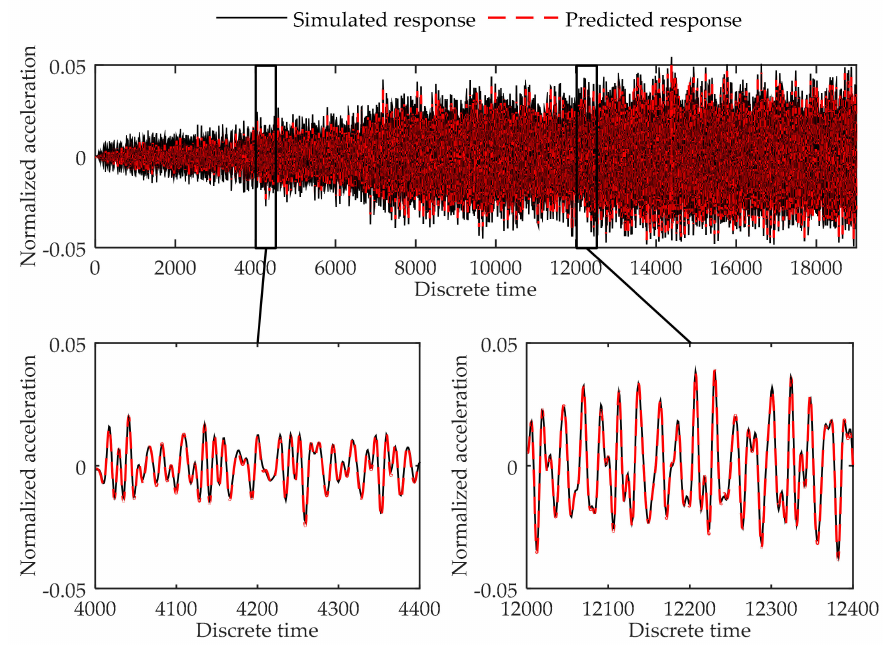
Figure 9. Comparison between the predicted response and simulated response of node 352 at the cantilever plate finite element model in Load Case